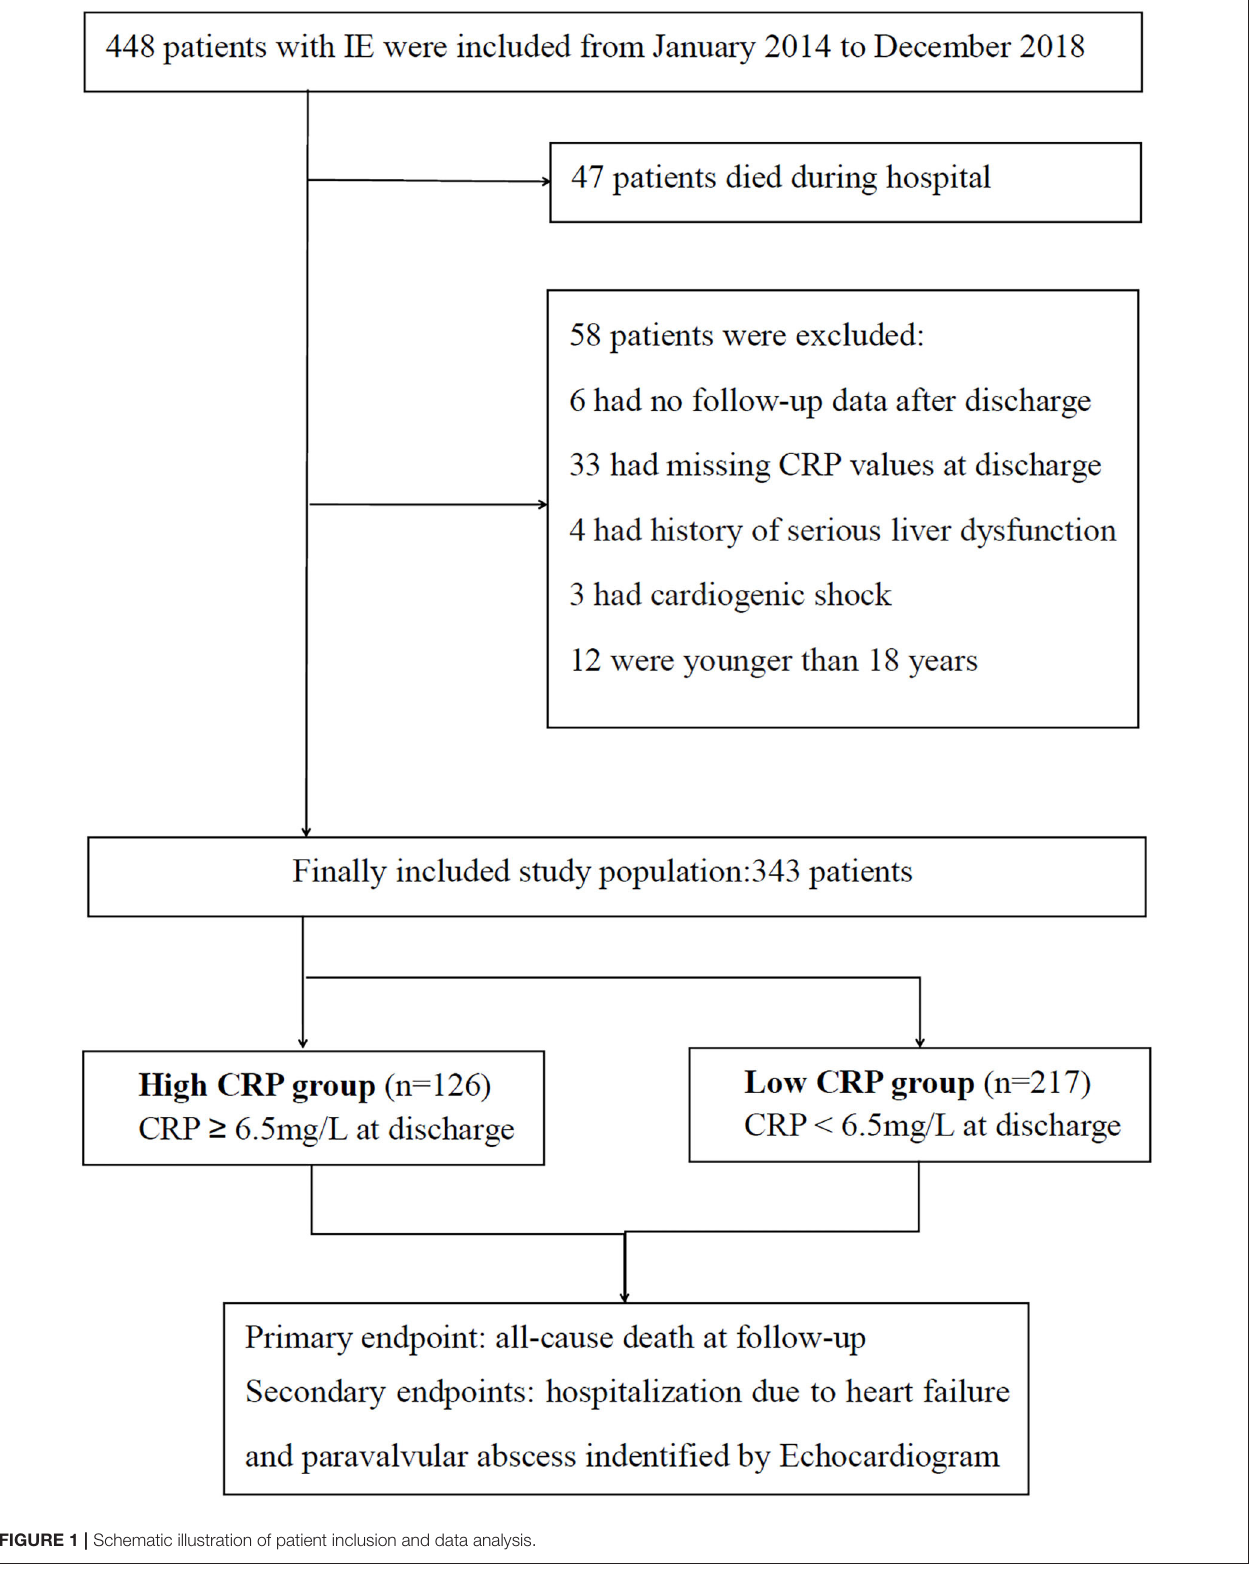
FIGURE 1 | Schematic illustration of patient inclusion and data analysis.